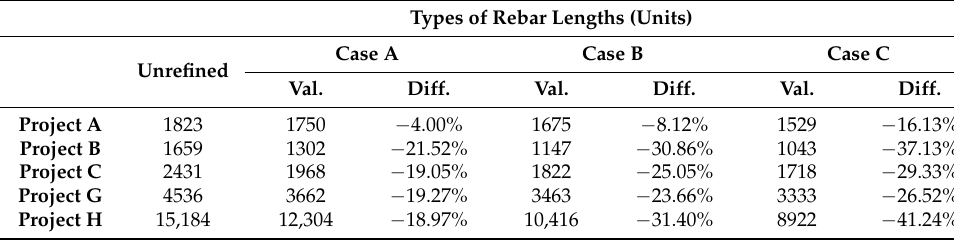
Table 6. Numbers of LPRS for Beam Members and Differentials by Cases.